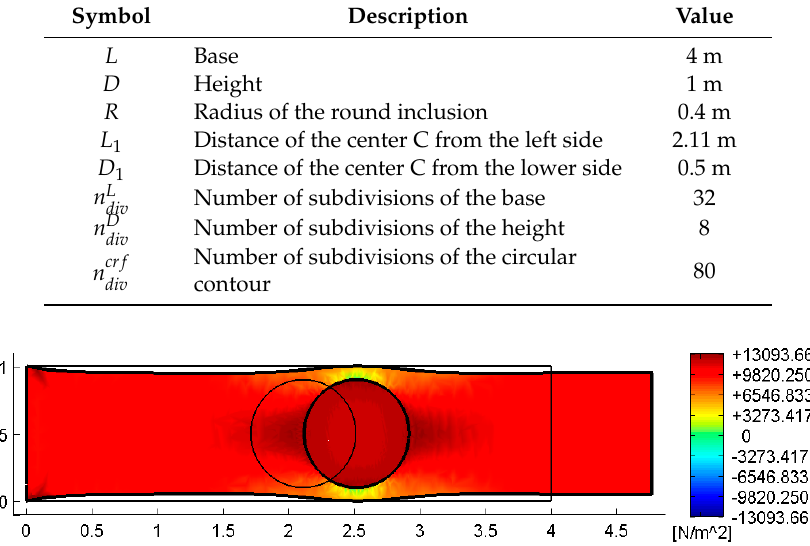
Figure 27. CM static analysis: normal stresses σ x plotted on the deformed configuration (Thin line: undeformed configuration. Thick line: deformed configuration. Amplification factor of the displacements: k = 500 ) [5].